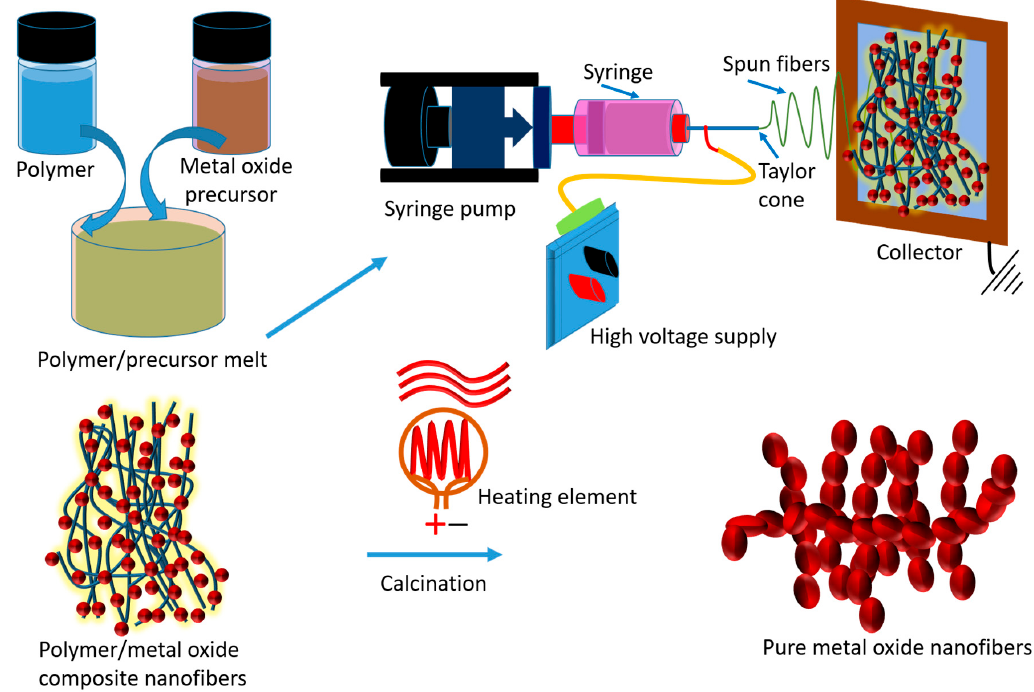
Figure 5. Electrospinning setup for fabrication of metal oxide nanofibers.